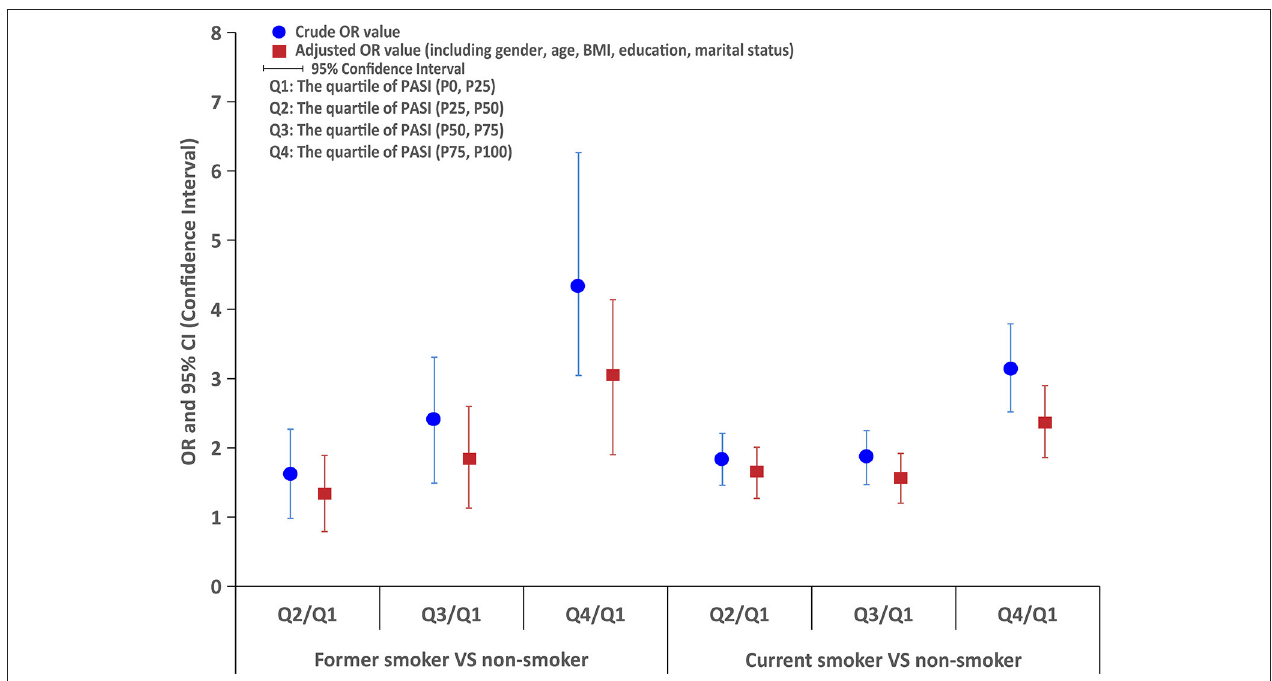
FIGURE 2 | The logistic regression analysis of PASI score between former smokers or current smokers and